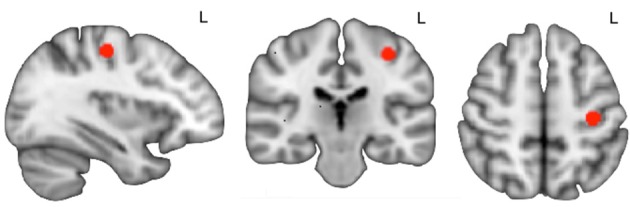
Seed region of interest (in red) overlaid on the T1 standard MNI template.